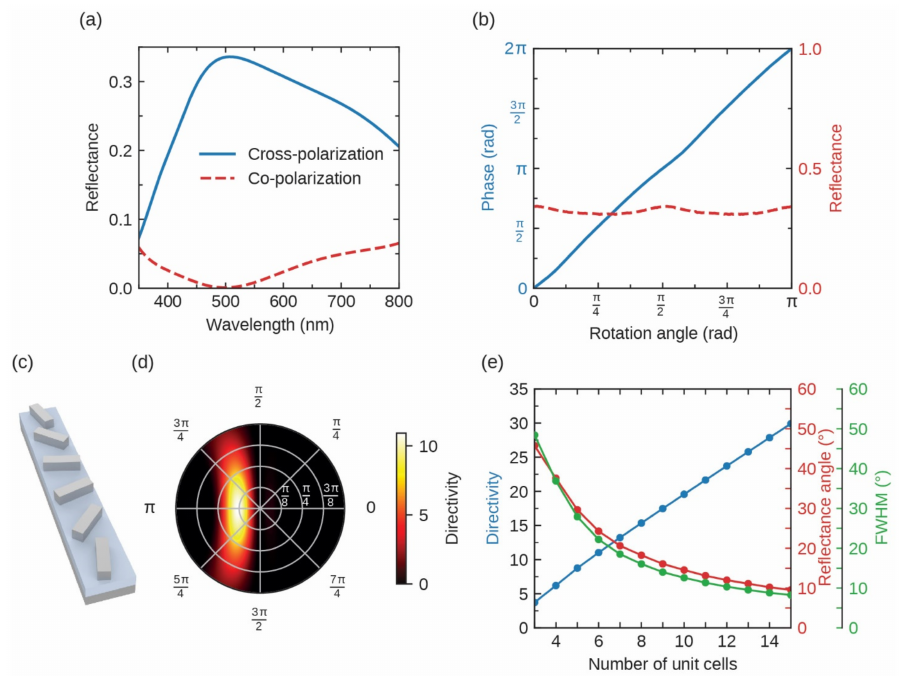
Figure 3. In all the figures ( a – e ), optimized Bi 2 Te 3 nanobricks with a length of 170 nm, a width of 45 nm, and a height of 45 nm, with a 200 nm pitch and a 50 nm SiO 2 spacer layer were used. ( a ) shows the reflectance spectra for co- and cross-polarized light for excitation with circular light with a conversion efficiency above 20% over nearly the entire visible spectrum and a maximum of 34% at 500 nm. In ( b ), the phase response of the nanobrick is shown for different rotational angles, achieving a 2 π phase coverage while the reflectance stayed nearly constant. In ( c ), a sketch of the supercells used in ( d ) is shown, which consisted of six nanobricks anomalously reflecting light at 24.3 ◦ , which is shown in the polar color plot in ( d ). φ is the angle in the x - y plane and represents the angular component ranging from 0 to 2 π , while the z -angle Θ is the radial component forming a hemispherical surface. A pronounced peak of a directivity of 11.0 is visible at Θ = 24.3 ◦ . The connection between the number of unit cells in each supercell and the parameter of the anomalously reflected beam is given in ( e ). FWHM: full width at half